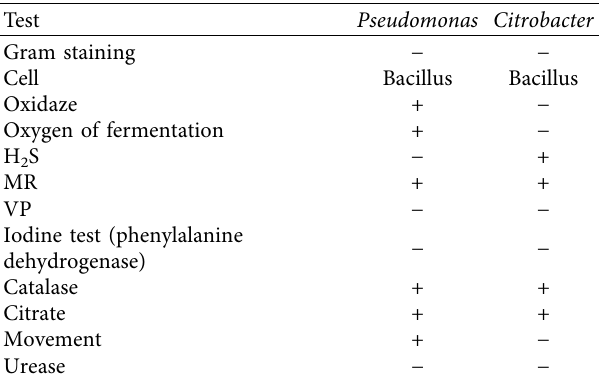
Figure 4: Microbial population trends in samples containing PYR. Table 2: Morphological and biochemical characteristics of two selected bacterial